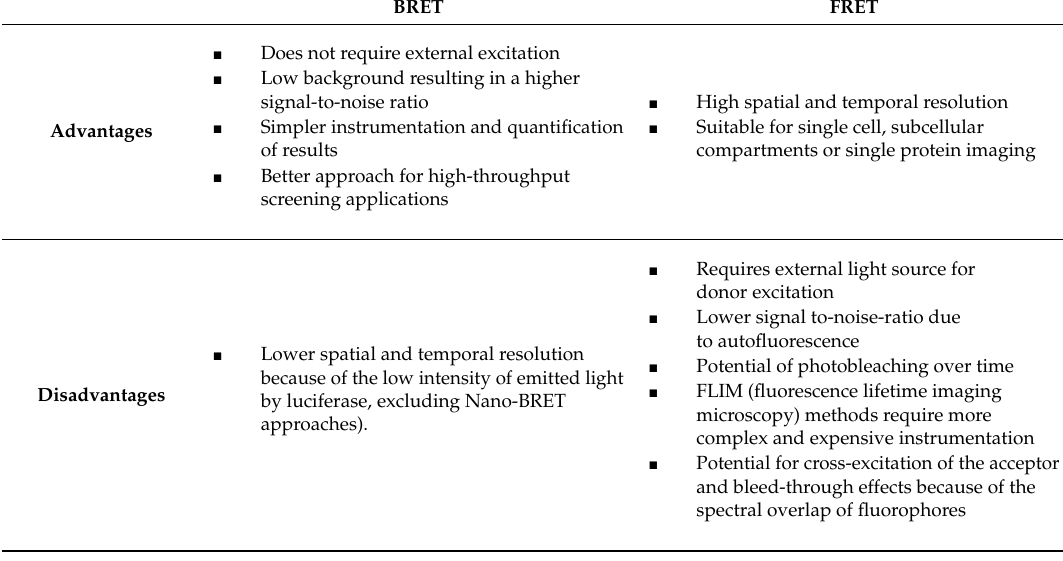
Table 1. Advantages and disadvantages of RET techniques- bioluminescence versus fluorescence resonance energy transfer-based sensors. (This has been extensively reviewed in Kauk et al.